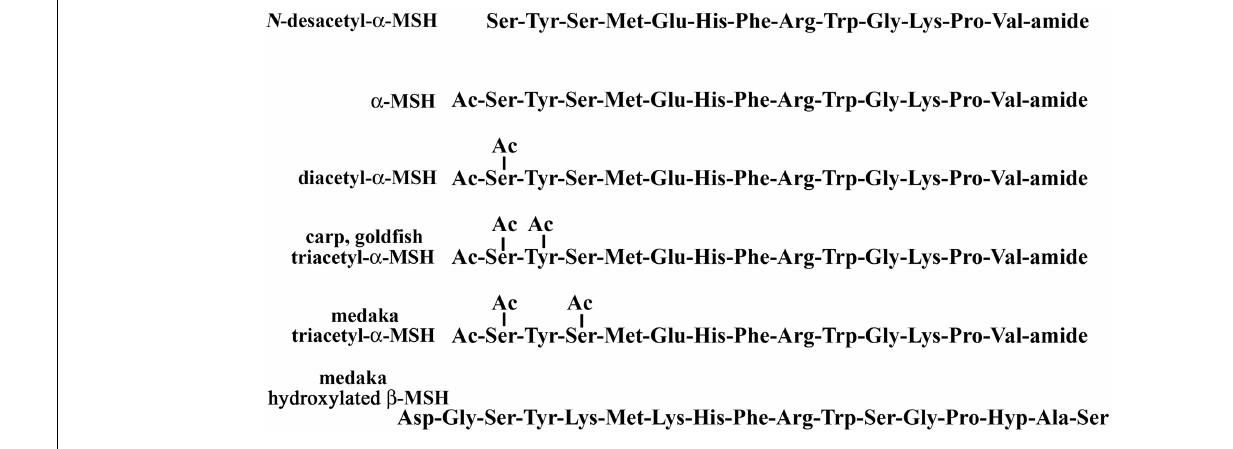
FIGURE 1 | Post-translational modifications of melanotropins in the pituitary